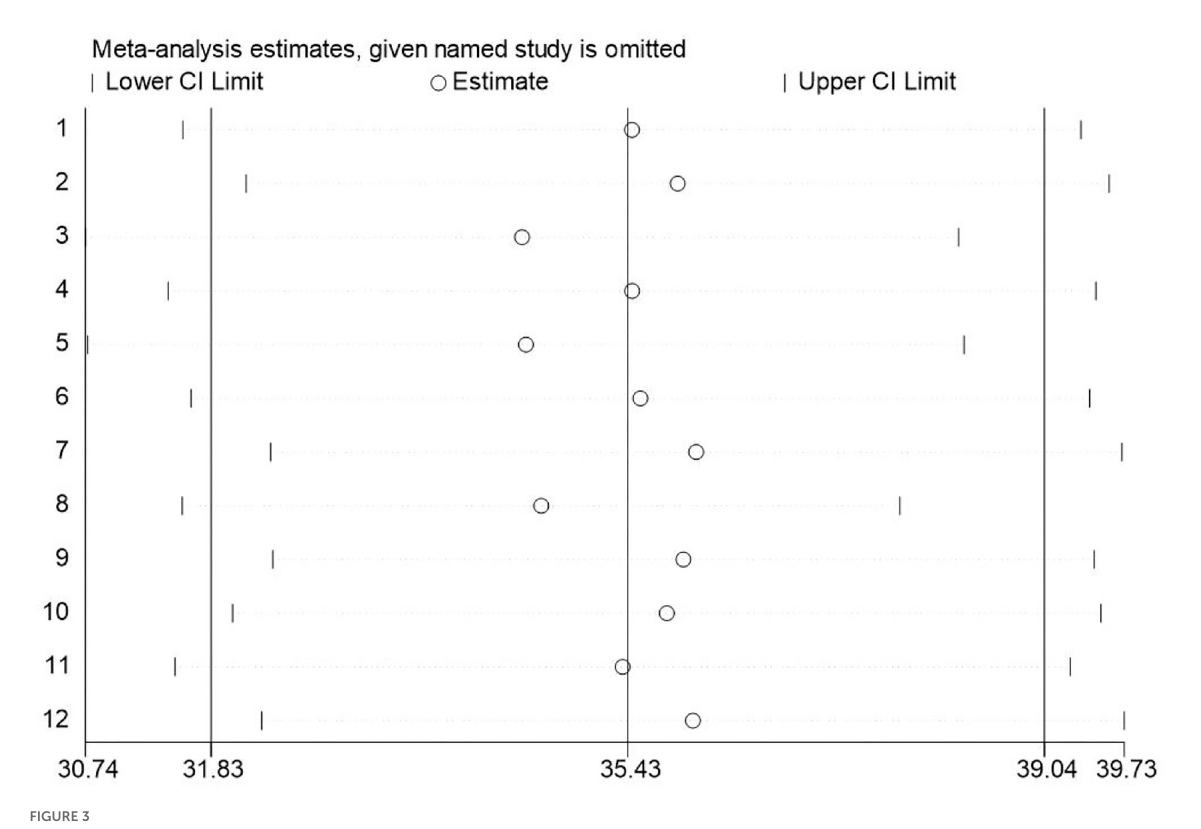
FIGURE3 Sensitivity